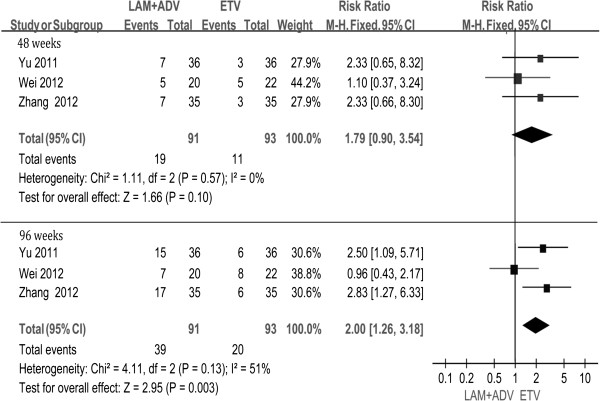
Effect of LAM + ADV vs. ETV on HBeAg seroconversion.